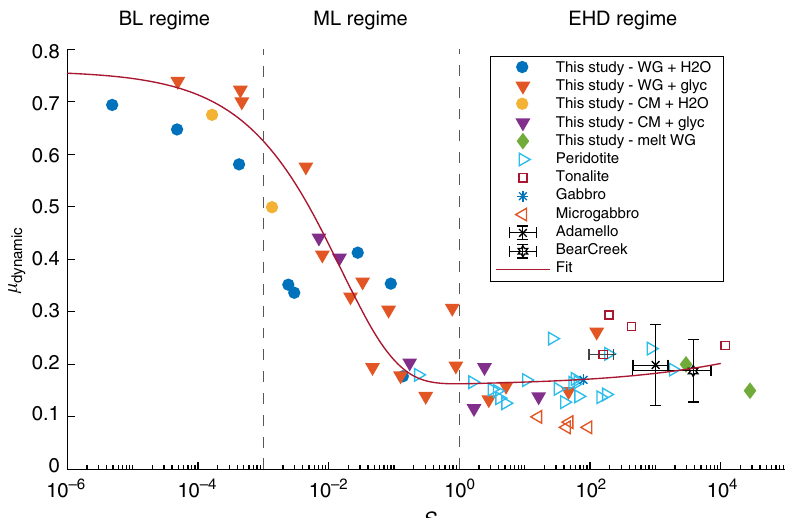
Fig. 2 Dynamic friction coef fi cient vs. Sommerfeld number. Experiments performed in water and glycerol presented in this study are compared with previous experiments with evidence of frictional melting performed on peridotite 31 , tonalite 32 , gabbro 33 , and microgabbro 10 (see symbols in the fi gure with WG for Westerly Granite and CM for Carrara Marble, see Supplementary Material Table 5). The viscosity of the melt for the room-humidity experiments were computed using the formulas proposed by Giordano et al. 50 . The H 0 values were considered constant for the experiments performed in presence of melt and equal to 13 μ m. The two black points with large error bars refer to fi eld estimation of S from pseudotachylyte-bearing faults (Gole Larghe fault zone in Adamello (Italy) and Bear Creek fault zone in Mount Abbot Quadrangle (USA)), see Supplementary Note 1. For S <10 − 3 , boundary lubrication regime, the dynamic friction coef fi cient is almost independent of S . For 10 − 3 < S <1, mixed lubrication regime, the dynamic friction coef fi cient decreases drastically with increasing S . For S >1, elastohydrodynamic lubrication regime, the dynamic friction increases slightly with S . The best- fi t curves are obtained using Eq. (1) (main text) with coef fi cients of determination of R 2 = 0.90. The scattering in µ dyn for S ≥ 1 is attributable to the viscosity of the fl uid given that τ ∝ η